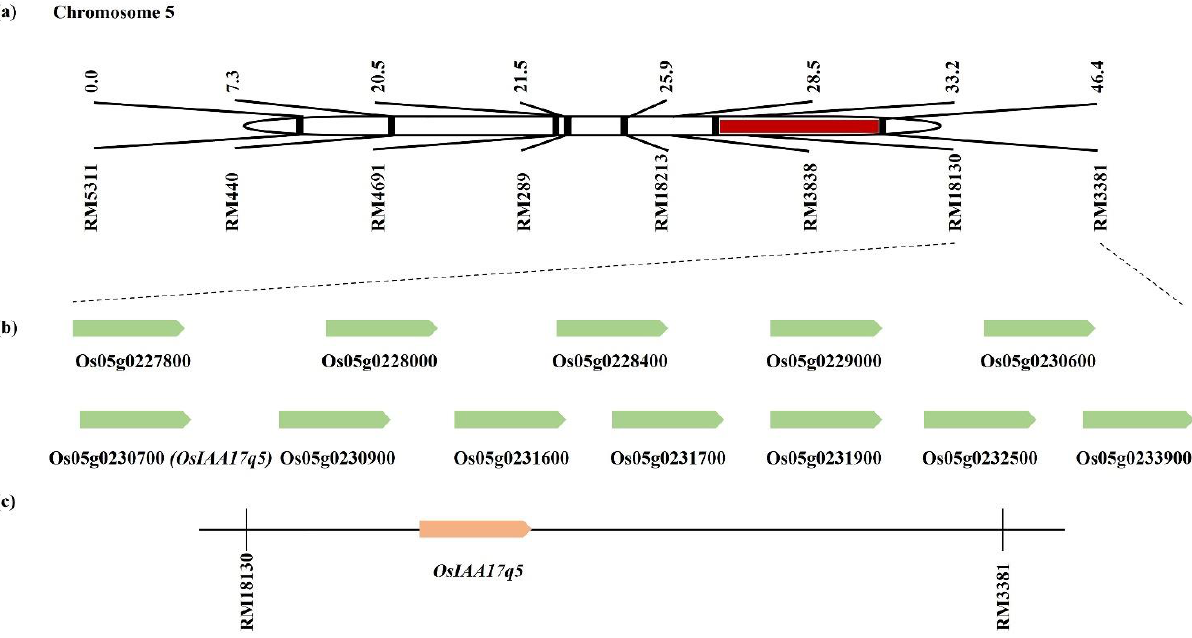
Figure 7. Physical mapping of the genes related to tiller number. ( a ) Target interval RM18130–RM3381 on chromosome 5. ( b ) In this case, 12 representative candidate genes located near the target gene OsIAA17q5 , between RM18130 and RM3381 on chromosome 5. ( c ) Screening of OsIAA17q5 , among the candidate genes, as a target gene-related to tiller number.